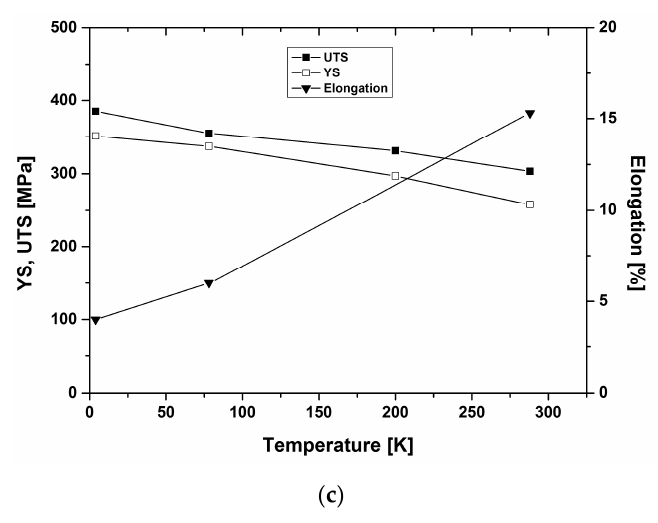
Figure 7. Mechanical properties of alloys ( a ) II4; ( b ) IA6; and ( c ) ZLH972 at low temperatures (after [21]).